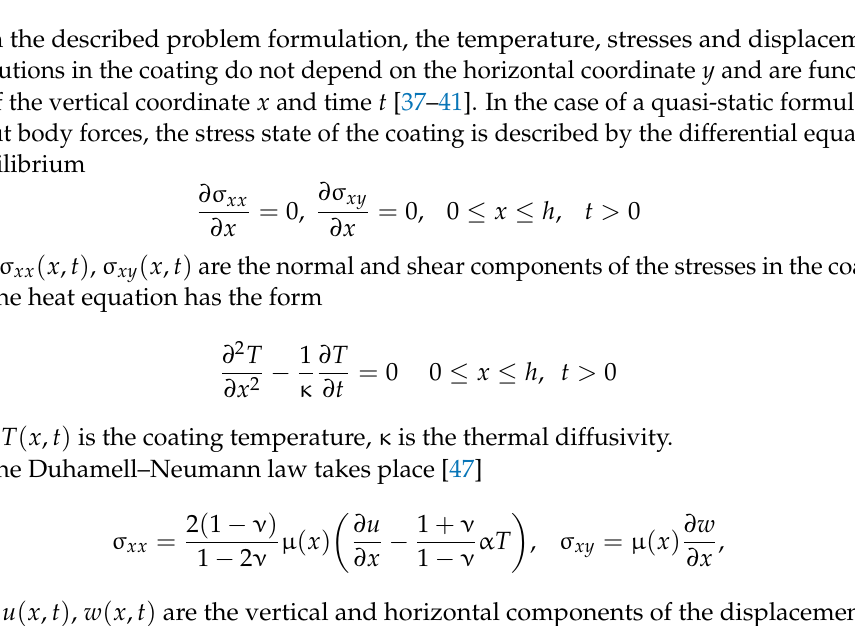
where u ( x , t ) , w ( x , t ) are the vertical and horizontal components of the displacements in the coating, µ ( x ) , ν , α are the shear modulus, Poisson’s ratio, coefficient of linear heat expansion of the coating material. of equilibrium Equation (1) and heat Equation (2), which together describe thermoelastic state of the